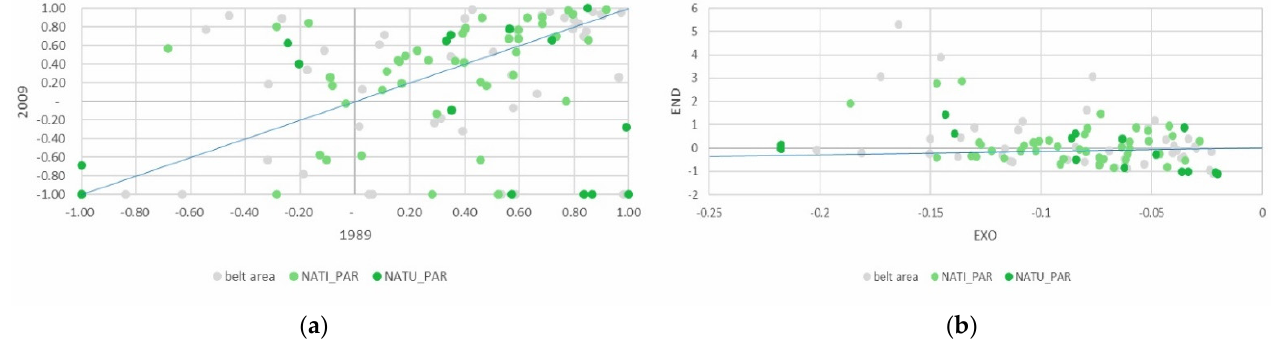
Figure 11. ( a , b ) Sierra Nevada- PSI and DPSI for sheep. Source: Drawn up by the authors using data from the 1989 and 2009 Agrarian Censuses, Ministry of Agriculture.